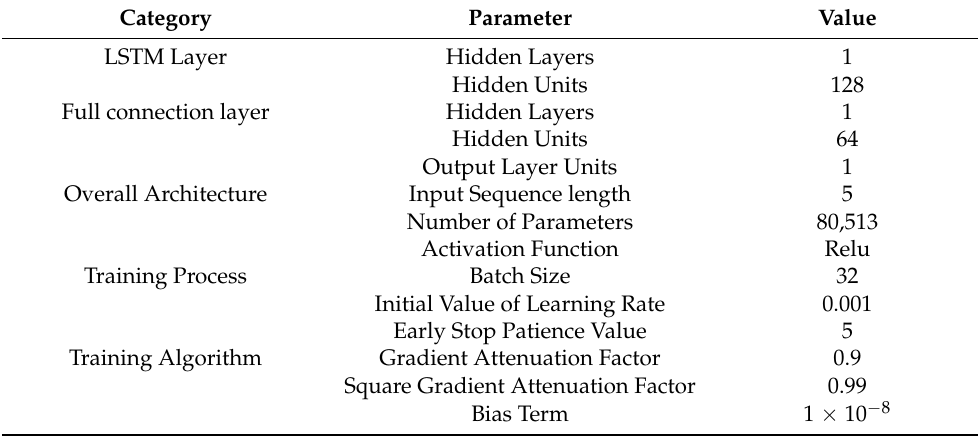
Table 2. Network Model Hyperparameters Setting.